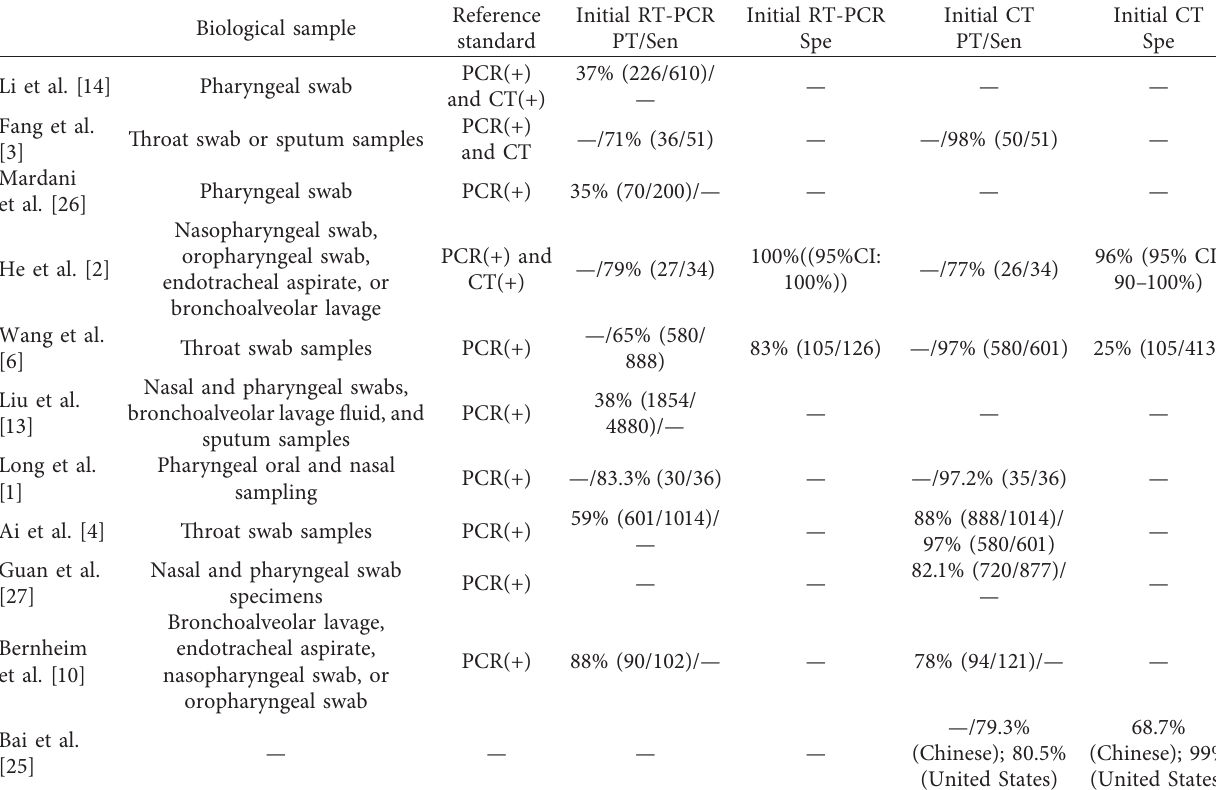
Table 1: The positive rate/sensitivity and specificity of initial RT-PCR and initial CT based on the published studies. Biological